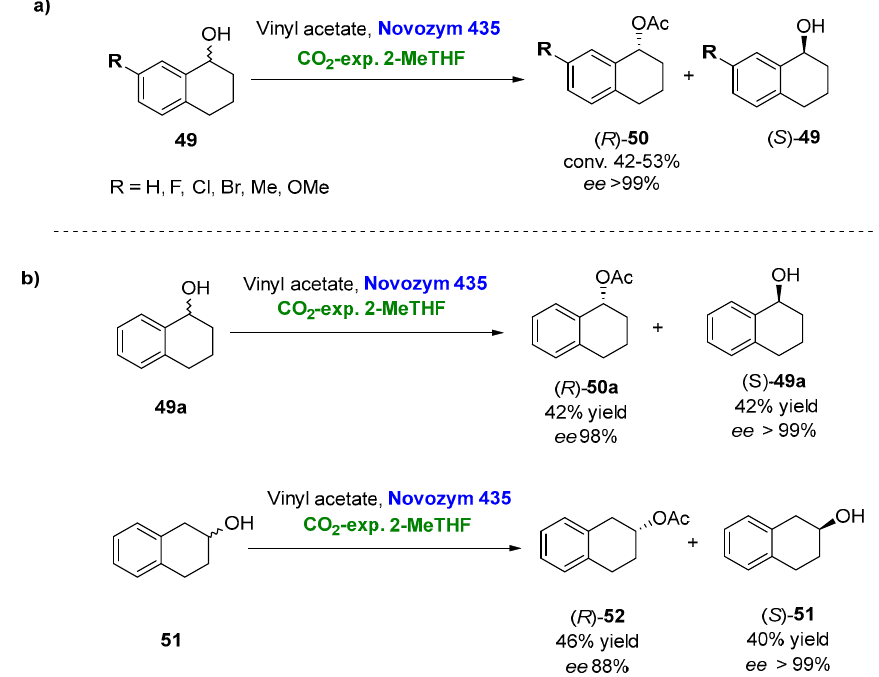
Figure 27. ( a ) Lipase-catalyzed resolution of racemic tetralols using CO 2 -expanded 2-MeTHF, ana- lytical scale. ( b ) Scaled (20 times) kinetic resolution of racemic 2-tetralol ( 51 ).